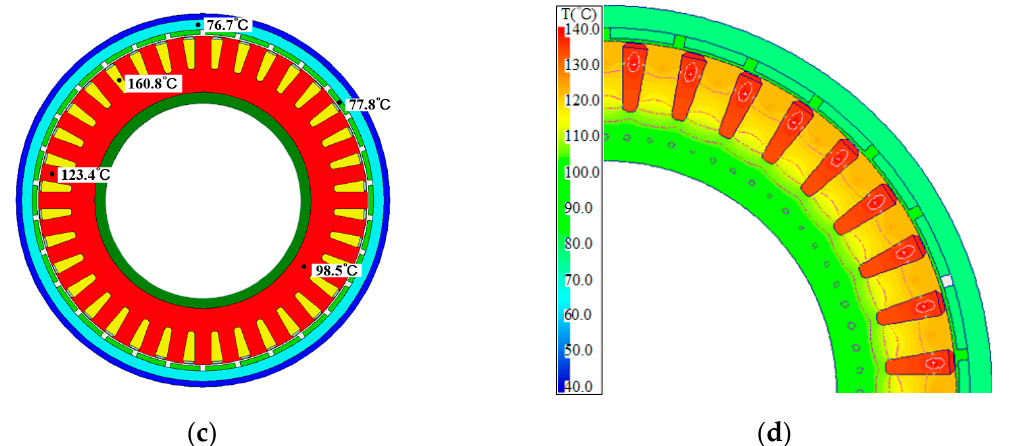
Figure 12. Temperature distributions under 2 A/mm 2 and 6 A/mm 2 : ( a ) whole temperature distribu- tion under 2 A/mm 2 ; ( b ) partial temperature distribution under 2 A/mm 2 ; ( c ) whole temperature distribution under 6 A/mm 2 ; ( d ) partial temperature distribution under 6 A/mm 2 .